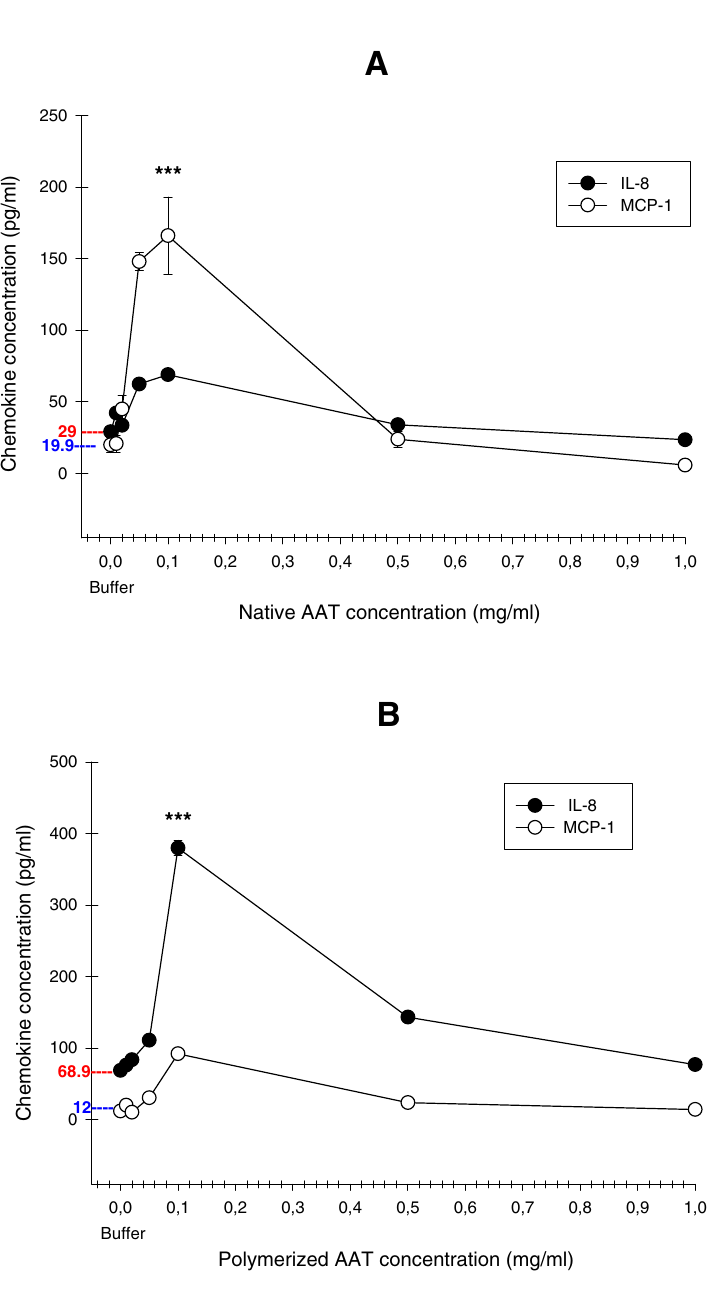
Figure 3 Chemokines released from monocytes stimulated with various concentrations of native (A) or polymerized (B) form of AAT. Each point represents the mean ± SD of six separate experiments. Significantly high up-regulation of the pro-inflammatory chemokines (IL-8 and MCP-1) was found when cells were treated with low doses (0.05 and 0.1 mg/ml) of native or polymer- ized AAT, respectively, compared to controls treated with equivalent amounts of buffer alone. The buffer control levels are indicated on the graphs (MCP-1 in blue and IL-8 in